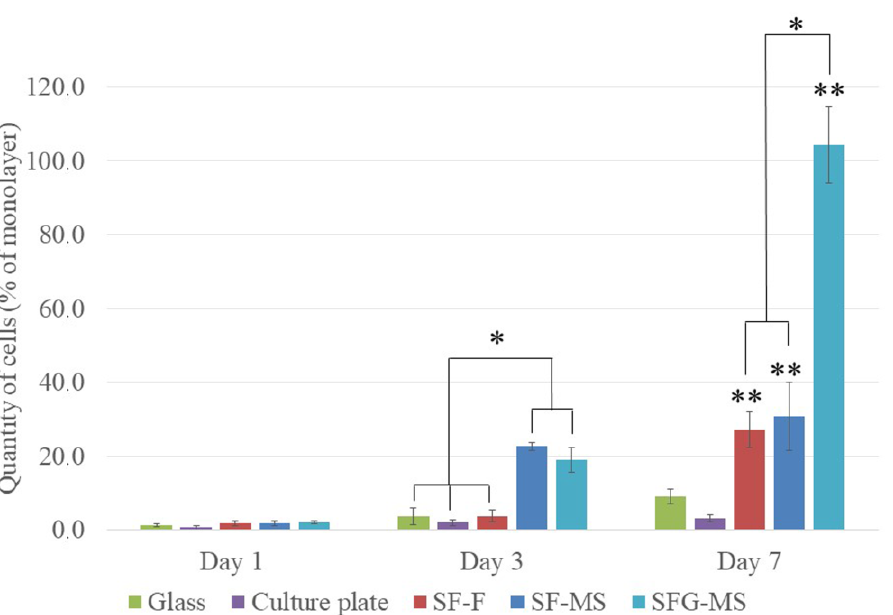
Figure 5. Adhesion (1 day) and proliferative activity (3 and 7 days) of mice 3T3 fibroblasts. The standard deviation values for 5 measurements are indicated. * indicates statistically significant differences between the experimental samples of constructions; ** marks statistically significant differences between the samples of constructions and the control samples.